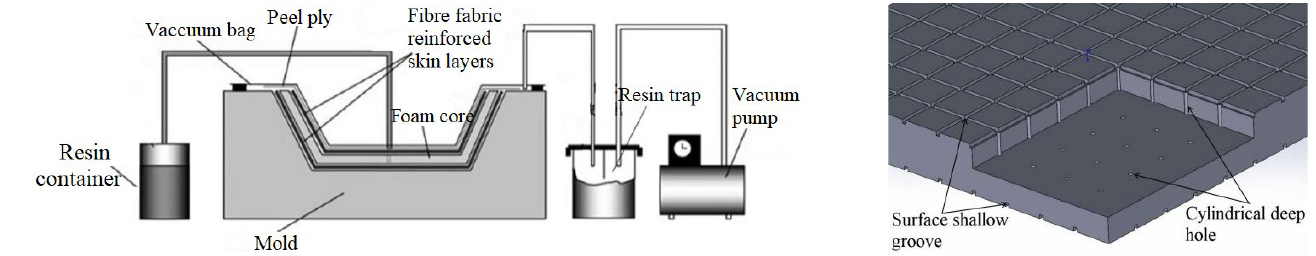
Figure 2. VARIM of the sandwich composites and its form core.